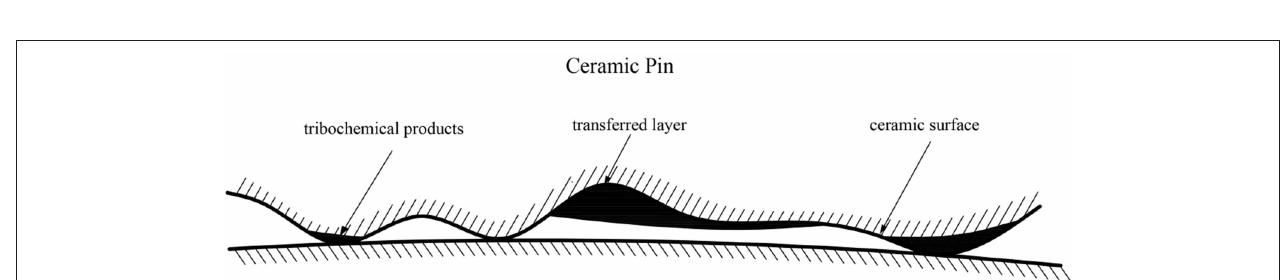
FIGURE 8 | Schematic diagram of ceramic pin surface.